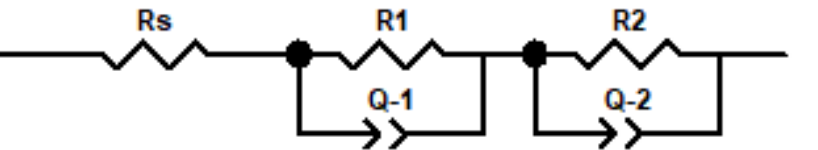
Figure 11. Electric equivalent circuit (EEC) used to model the photovoltaic devices impedance spectra in the dark and under illumination.